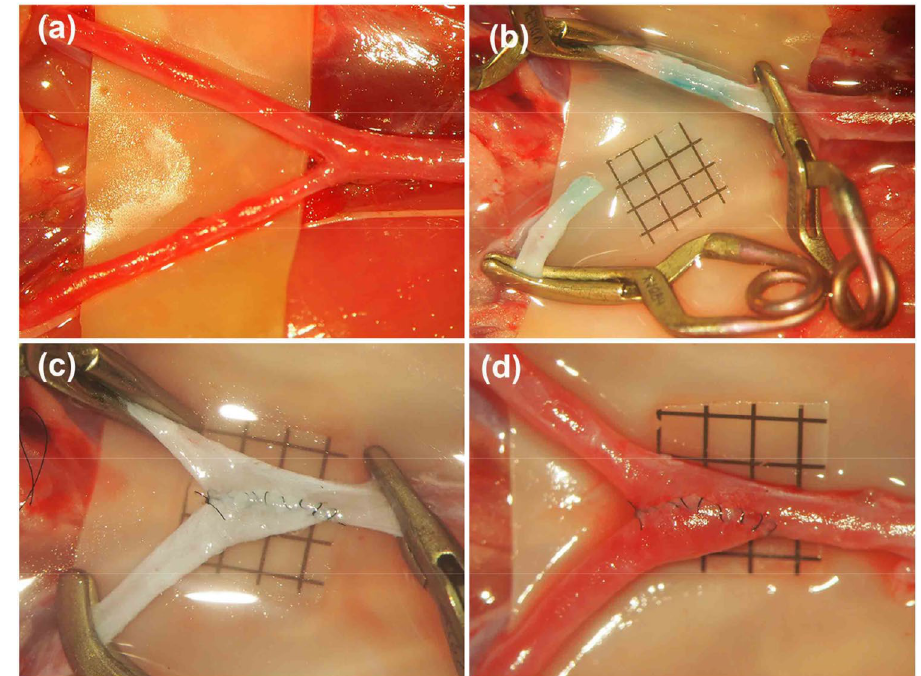
Figure 6. End-to-side anastomosis between bilateral common iliac arteries. After both common iliac arteries were carefully dissected ( a ). The left common iliac artery was temporarily clipped and cut at its origin from the abdominal aorta, the right common iliac artery was also temporarily clipped ( b ). The end-to-side anastomosis was completed with the intraluminal continuous suturing technique ( c ) and the blood flow was restored ( d ). (Scale bar = 1